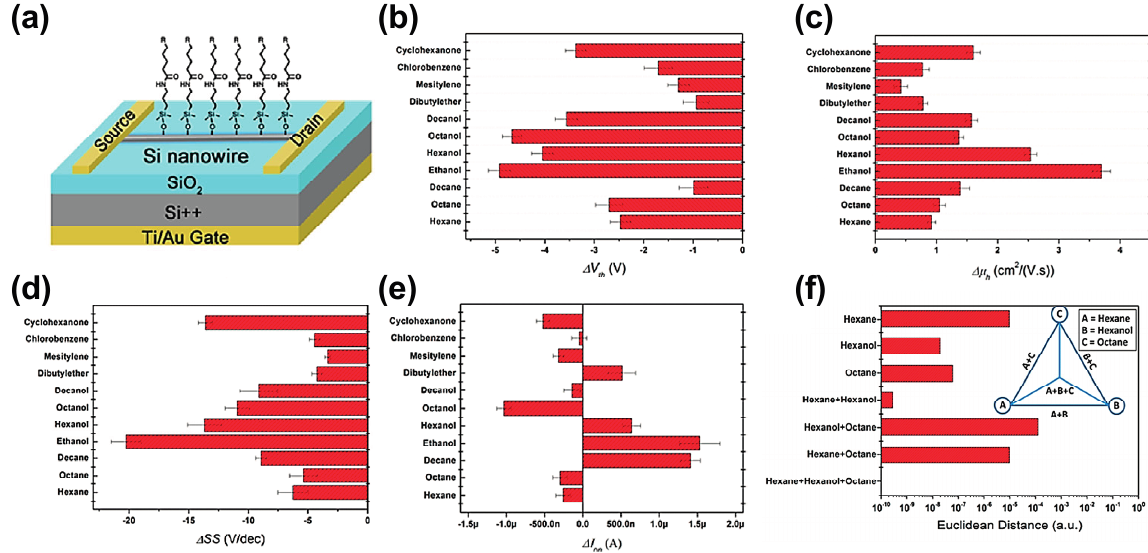
Figure 6. ( a ) Scheme of a molecularly modified Si nanowire field-effect